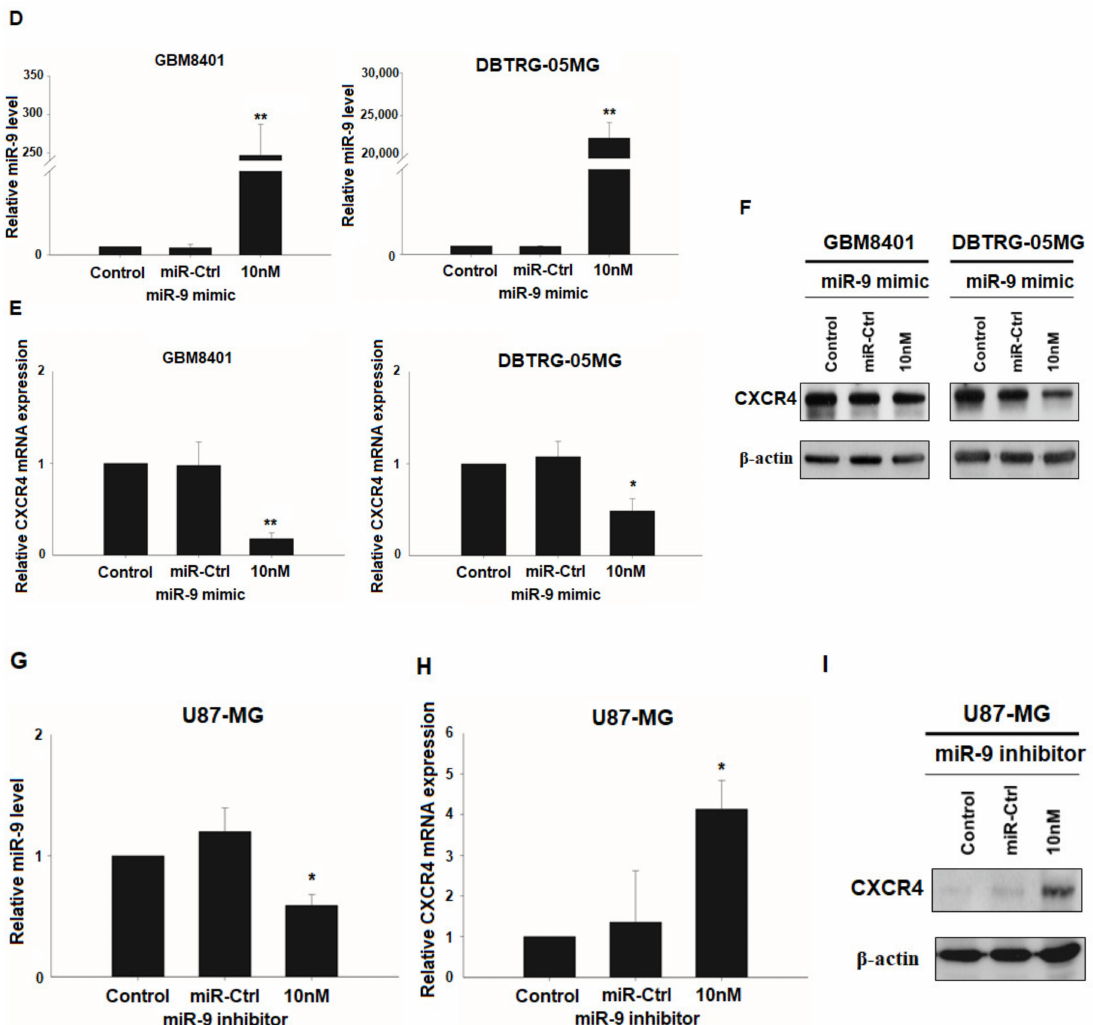
Figure 3. CXCR4 is a target of miR-9. ( A ) The intersection of the analyses using the three algorithms (miRWalk, Pictar, and TargetScan) is shown for the miRNAs that were predicted to target CXCR4 and those that were di ff erentially regulated. ( B ) Binding site of miR-9 predicted in the CXCR4 3 (cid:48) UTR by TargetScan. ( C ) Di ff erential expression of miR-9 in U87-MG, GBM8401, and DBTRG-05MG cells. The expression of miR-9 was determined using qRT-PCR. ( D ) The e ff ect of the miR-9 mimic (10 nM) in the indicated cells was evaluated using qRT-PCR. ( E ) The relative CXCR4 mRNA levels in GBM8401 and DBTRG-05MG cells 48 h after transfection of the miR-9 mimic (10 nM) or miR-Ctrl ( F ) The protein levels of CXCR4 were measured by Western blotting. β -actin was used as an endogenous control. ( G ) The e ff ect of the miR-9 inhibitor (10 nM) on the miR-9 level in U87-MG cells was evaluated using qRT-PCR. Cells were transfected with miR-9 inhibitor or control, and CXCR4 mRNA ( H ) and protein ( I ) were determined 48 h after transfection. Mean ± SD, n = 3. * p < 0.05; ** p < 0.01. The raw data of Western blots is shown in Figure